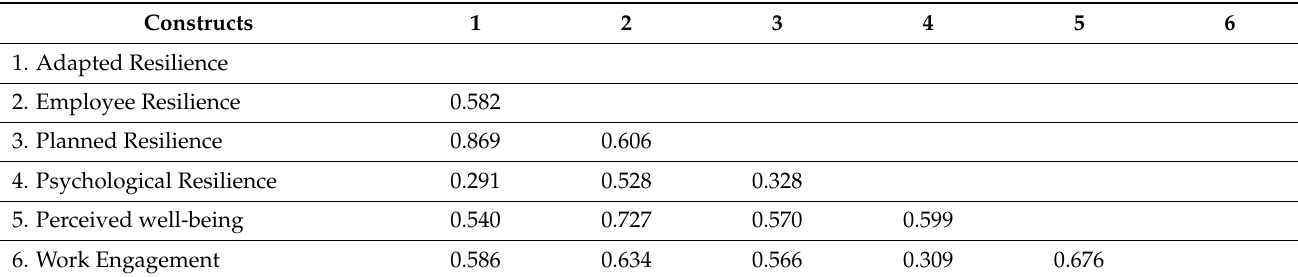
Table 3. Assessing Discriminant Validity